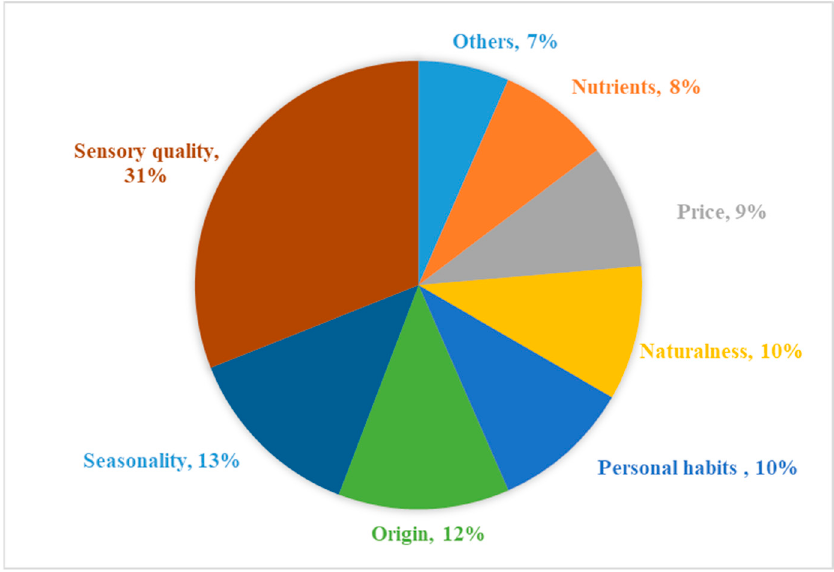
Figure 1. Frequency distribution of factors considered at point of purchase.